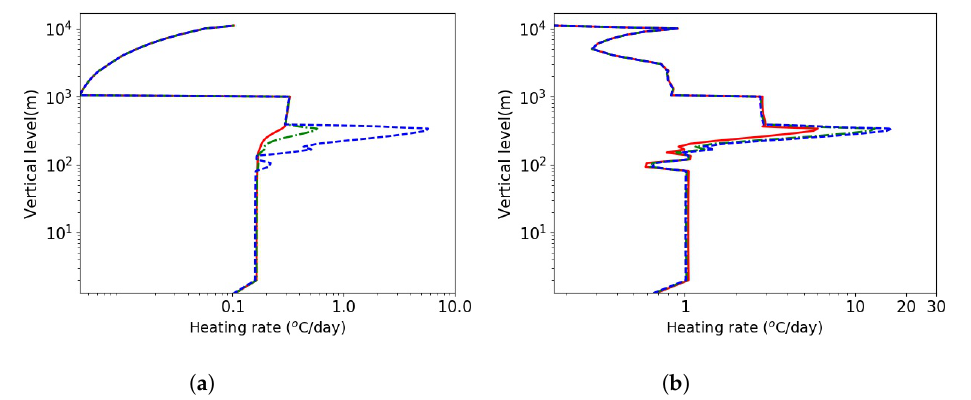
Figure 7. Heating rate in the atmospheric layers at 0900 (UTC) on the 19 of February for UV-vis band ( a ) and for SIR band ( b ) (for ‘stationary case’) ( — base case, i.e., without BC; -.- V fBC = 8.6 × 10 − 6 ; - - - V fBC = 1.6 × 10 − 4